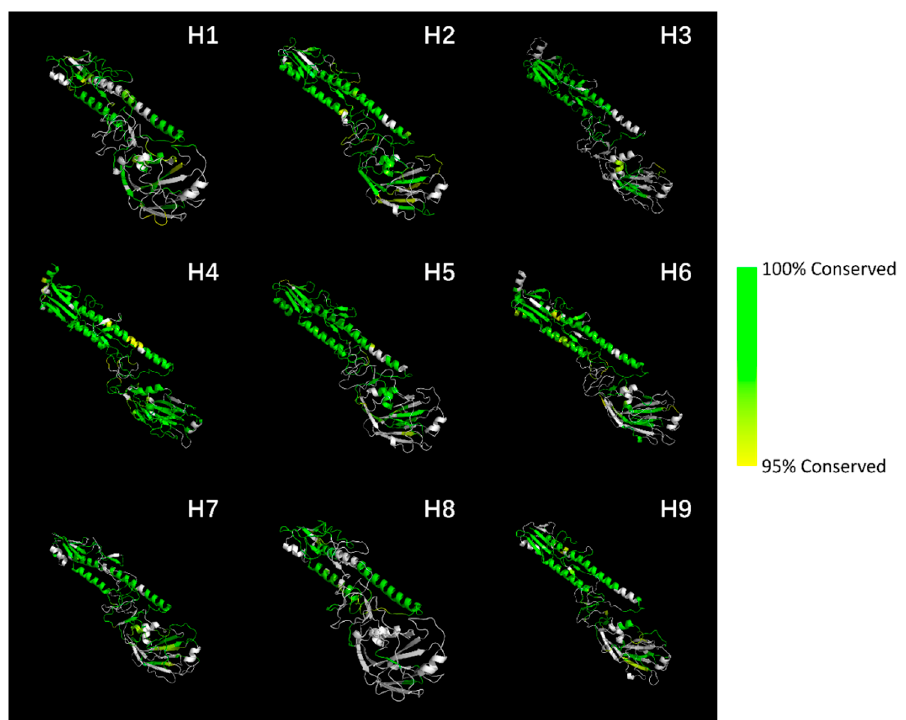
Figure 1. Visualization of HA protein conserved sequence mapping on spatial structure. The influenza virus HA protein is a homotrimer. We removed duplicate parts for enhanced presentation. The structures of H1 (1ruz) [20], H2 (2wr0) [21], H3 (4uo0) [22], H4 (5xl1) [23], H5 (1jsm) [24], H6 (5t08) [25], H7 (1ti8) [26], and H9 (1jsd) [24] are from the Protein Data Bank database [27]. The structure of the H8 subtype is from H1 structure’s homologous modelling [28]. The colors from green (RGB:010) to yellow (RGB:110) represent different conservative rates from 100 to 95%; conservative rates lower than 95% are colored in white.